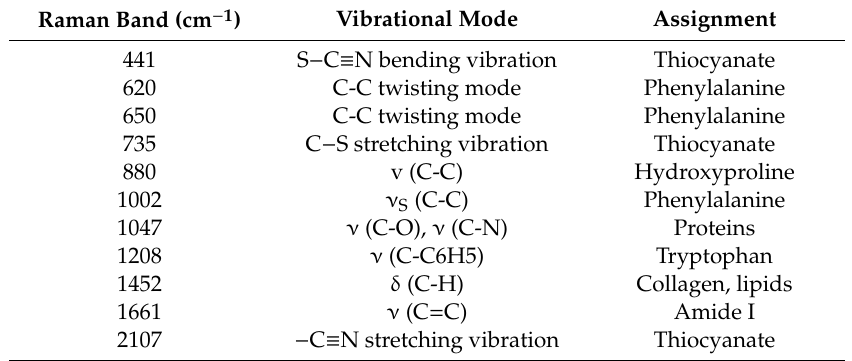
Table 1. Assignment of the vibrational peaks recorded in the SERS spectra of human